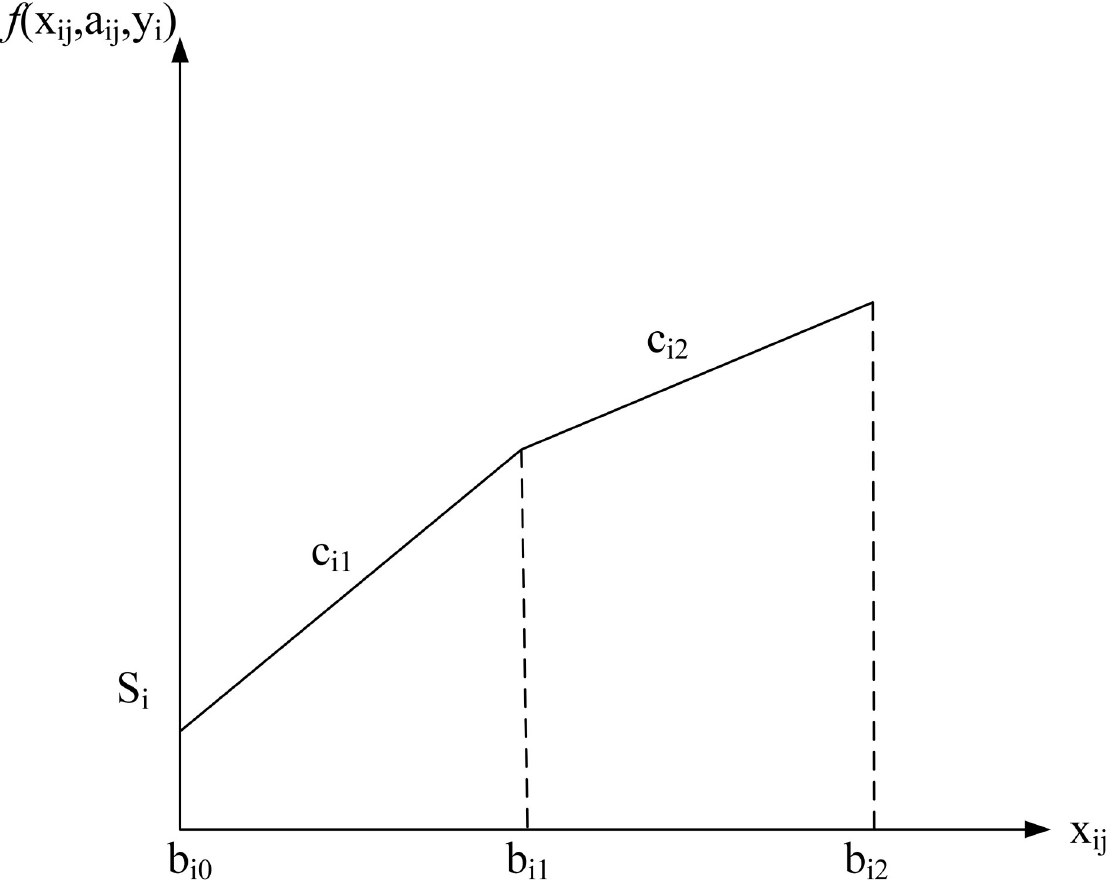
Fig 4. Incremental discount (2